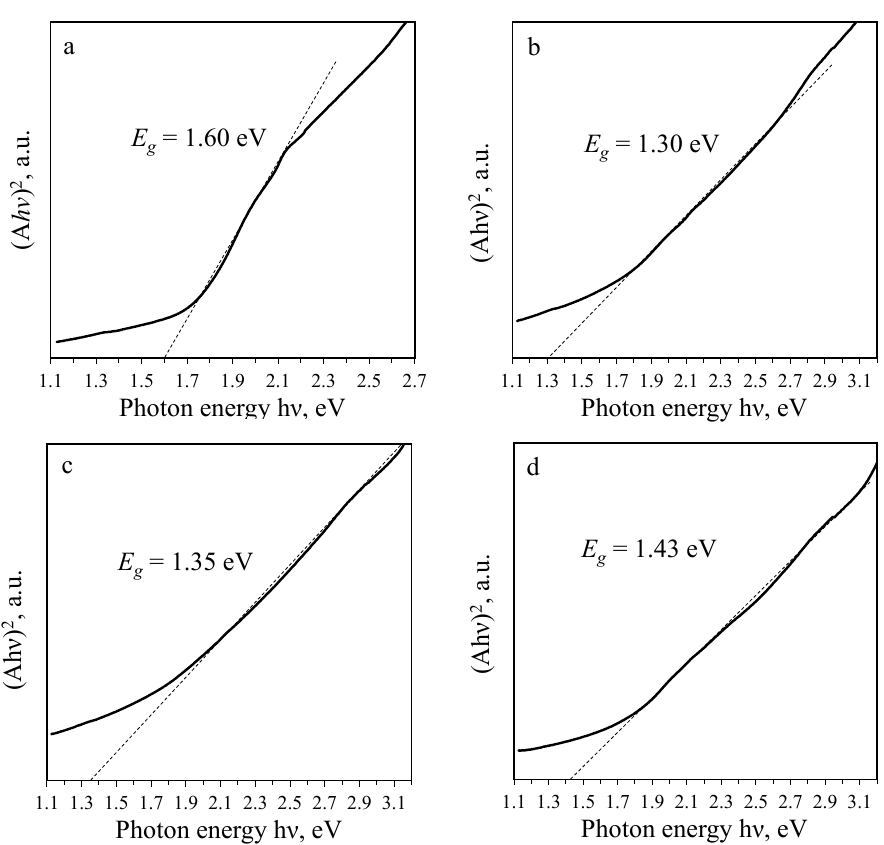
Figure 6. Tauc plot of obtained films on glass: ( a ) after selenization, ( b ) after treatment with cop- per(II/I) ion solution at 60 °C for 5 min, ( c ) after In-incorporation, and ( d ) after annealing.